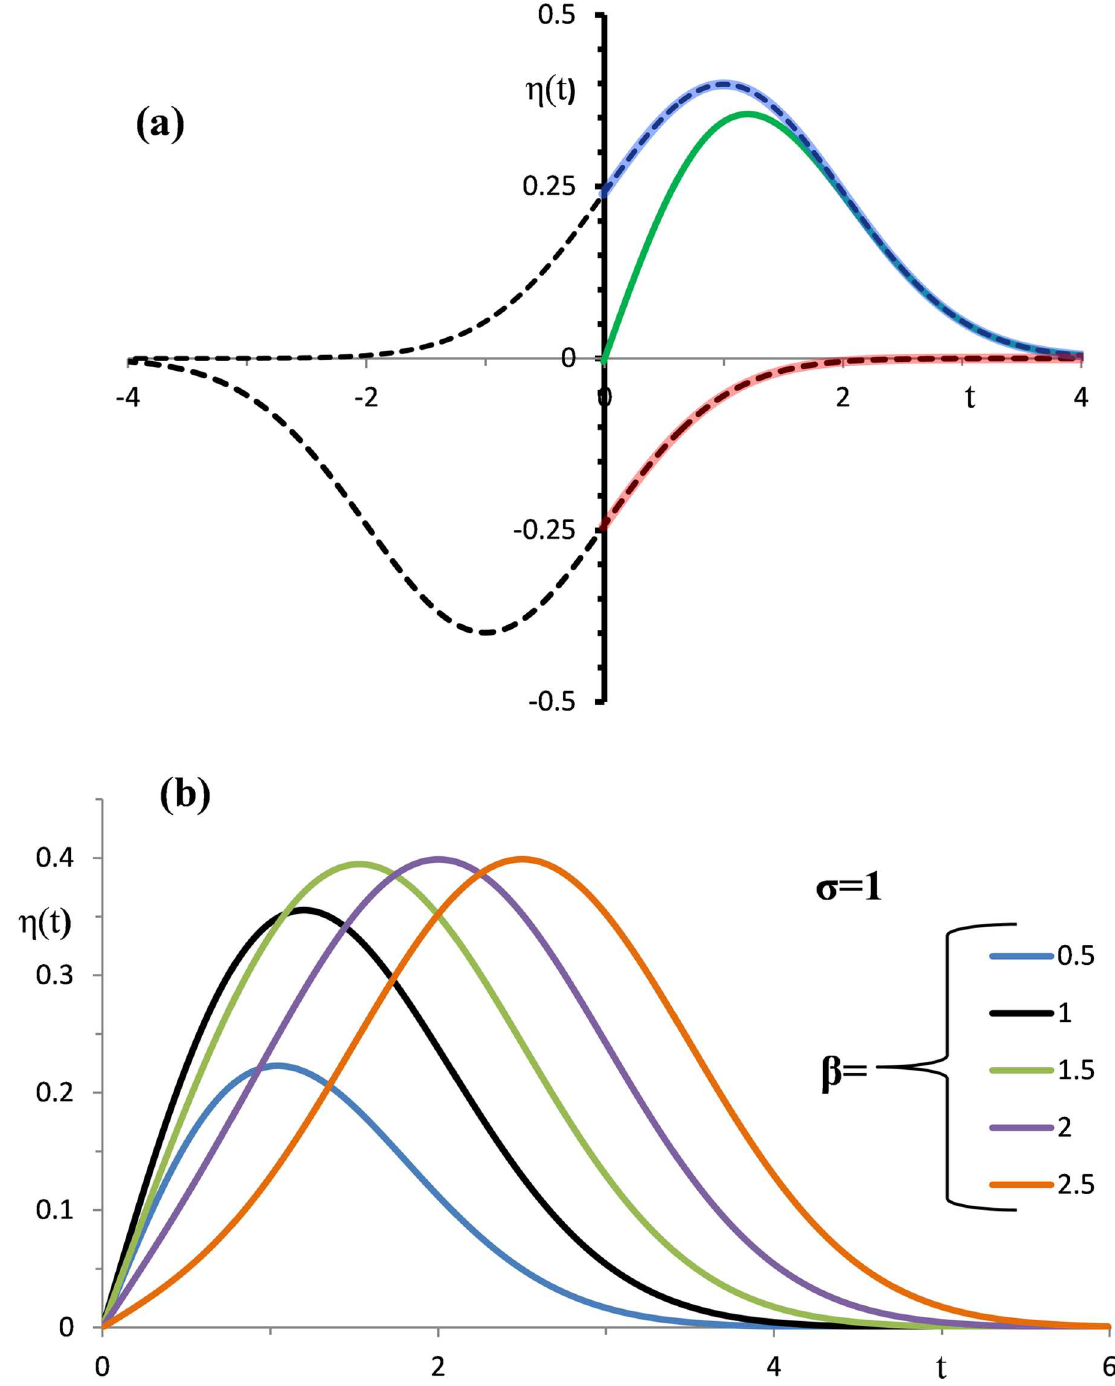
Fig 5. Half-wave function and its components. (a) The green, blue, and red solid lines show η (t), η P (t), and η S (t) with σ = β = 1 parameters. The dotted lines are Gaussian functions which disclose η P (t) and η S (t) as fragments of the two shifted curves of normal distributions. (b) Effects of varying β on the shapes of η (t) with σ =